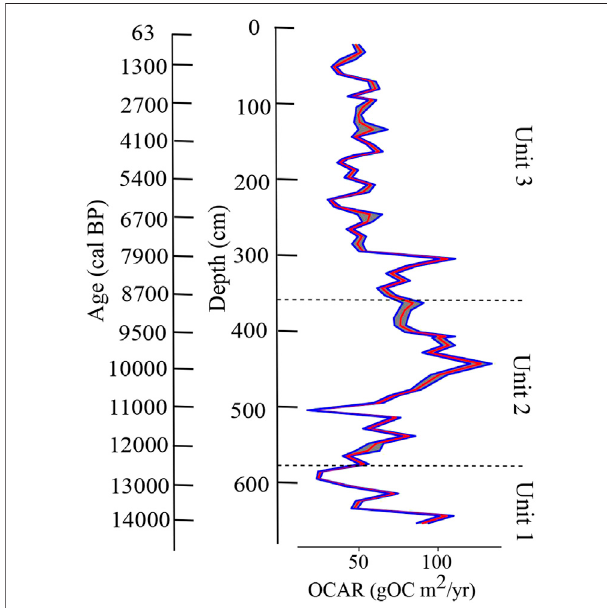
FIGURE 7 | δ 13 C versus TOC/TN atomic ratio of 78 discrete samples. Lacustrine algae, C 3 land plant, and C 4 land plant designations from Meyers and Teranes,